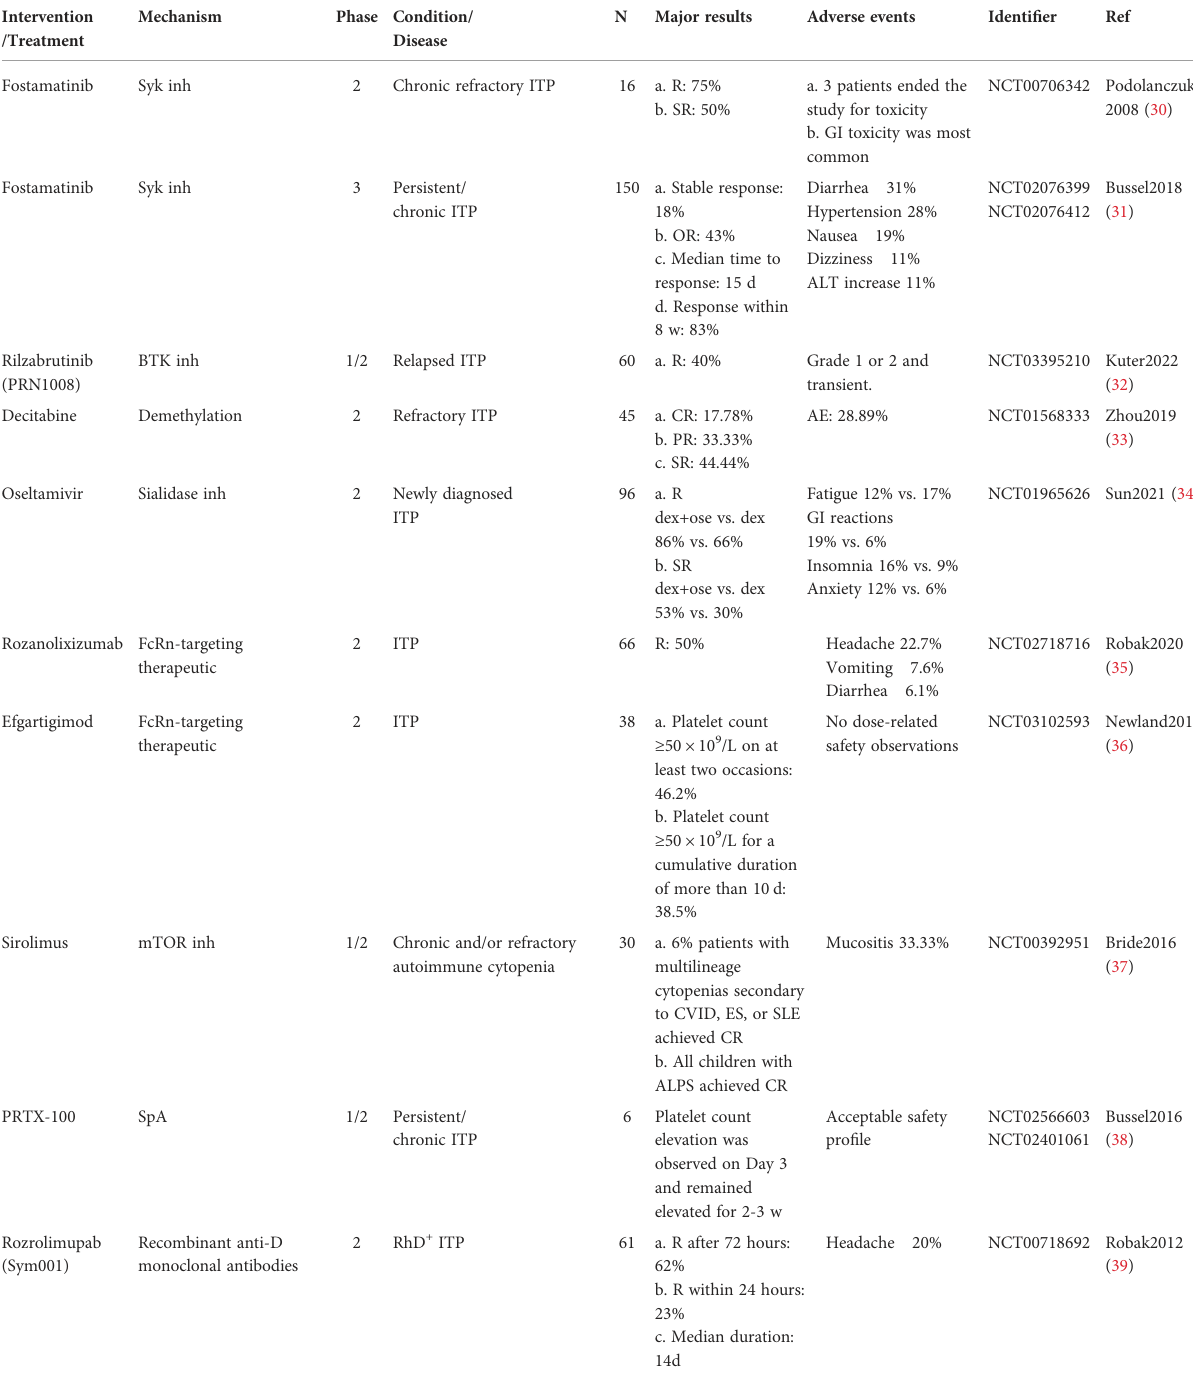
TABLE 1 Emerging therapies in refractory